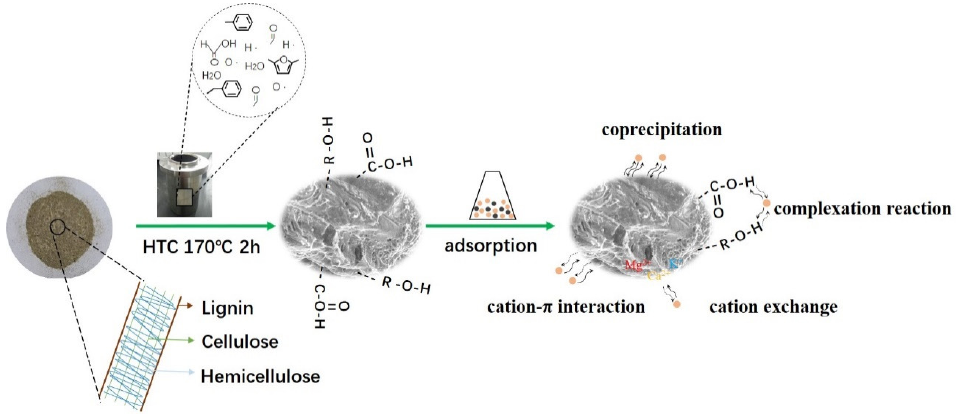
Figure 12. HTC process of corn straw and mechanism of adsorption of Cd 2+.